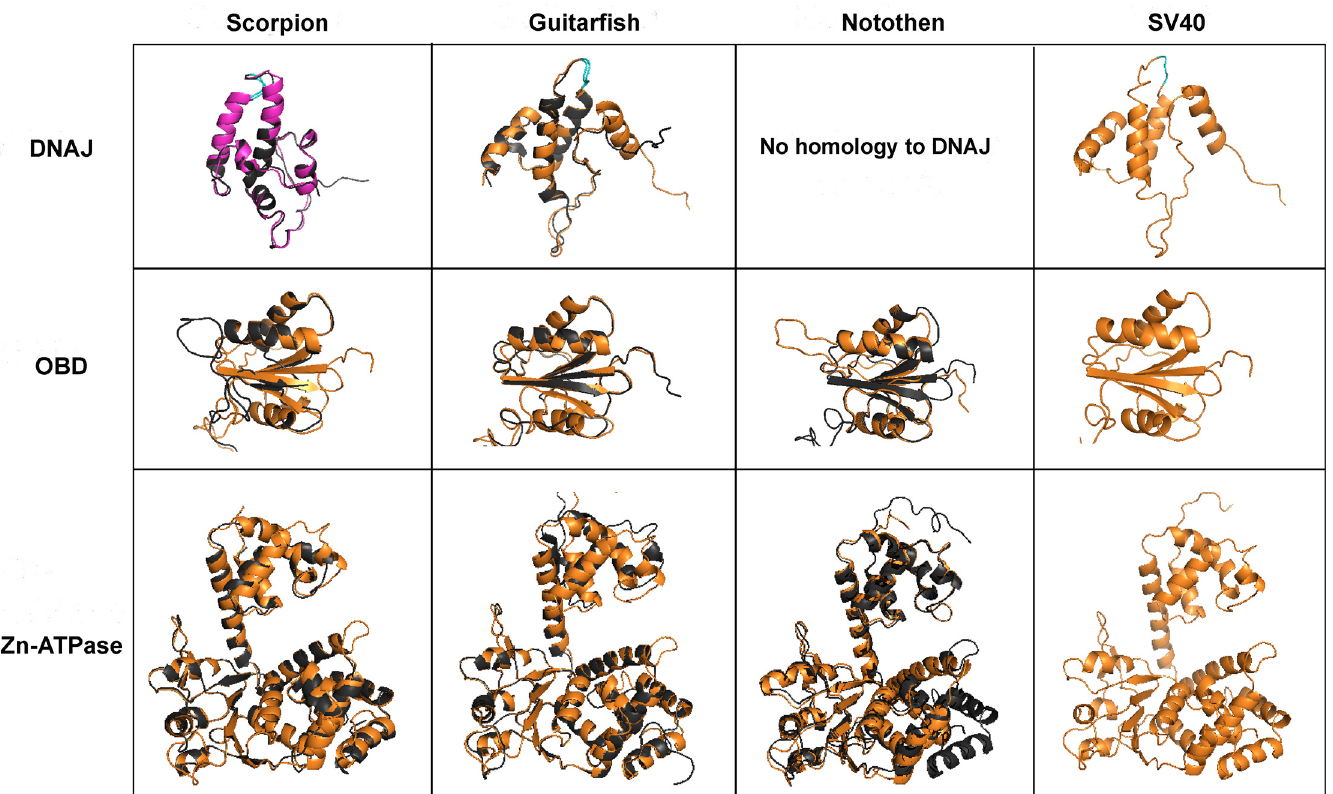
Fig 2. Structural modeling of LT proteins. The solved OBD-Zn-ATPase SV40 LT structure (PDB identifier 4GDF) was used as template for all OBD and Zn-ATPase domain models. The model of the guitarfish polyomavirus J domain was generated using the solved structure of the SV40 LT DNAJ domain (PDB identifier 1GH6) as template. For the DNAJ domain of scorpion polyomavirus LT, the best modeling template match is a Thermus thermophilus DNAJ protein (PDB identifier 4J7Z). The solved structure of the bacterial DNAJ is highlighted in magenta in the pairwise superimposition (top left). The LT proteins of the indicated polyomavirus species are shown in black. The known structures of SV40 LT domains are superimposed in gold. The conserved HPD motif of the DNAJ domain is positioned on the top and highlighted in cyan. The N-terminal domain of the notothen polyomavirus has no discernible structural similarity to known DNAJ